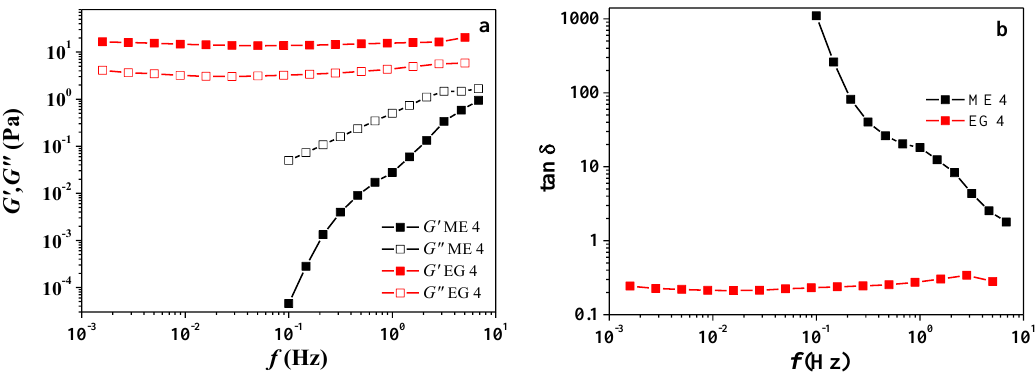
Figure 1. Frequency dependence of the storage (G ′ ) and loss (G ″ ) moduli ( a ); the loss tangent for ME 4 and EG 4 ( b ).